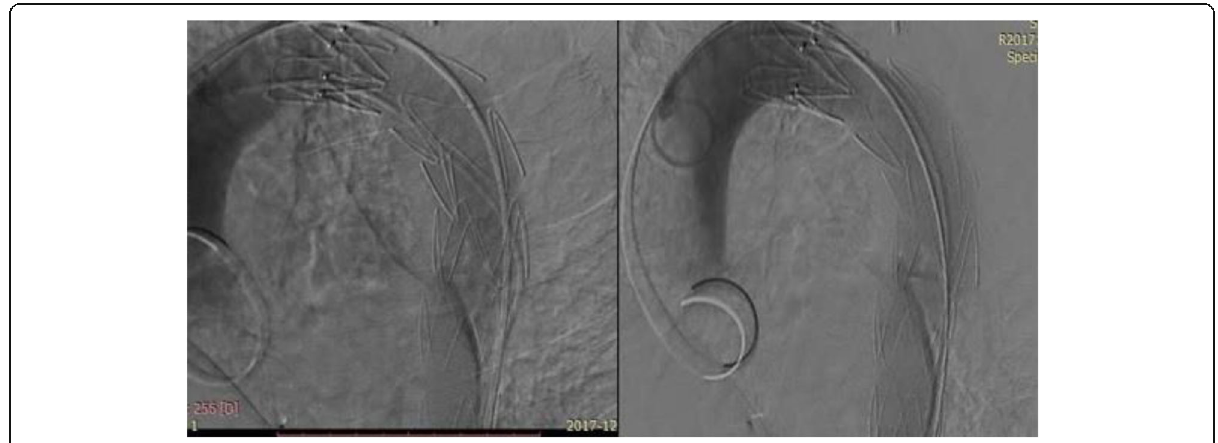
Fig. 5 Stent graft deployed just after left carotid artery